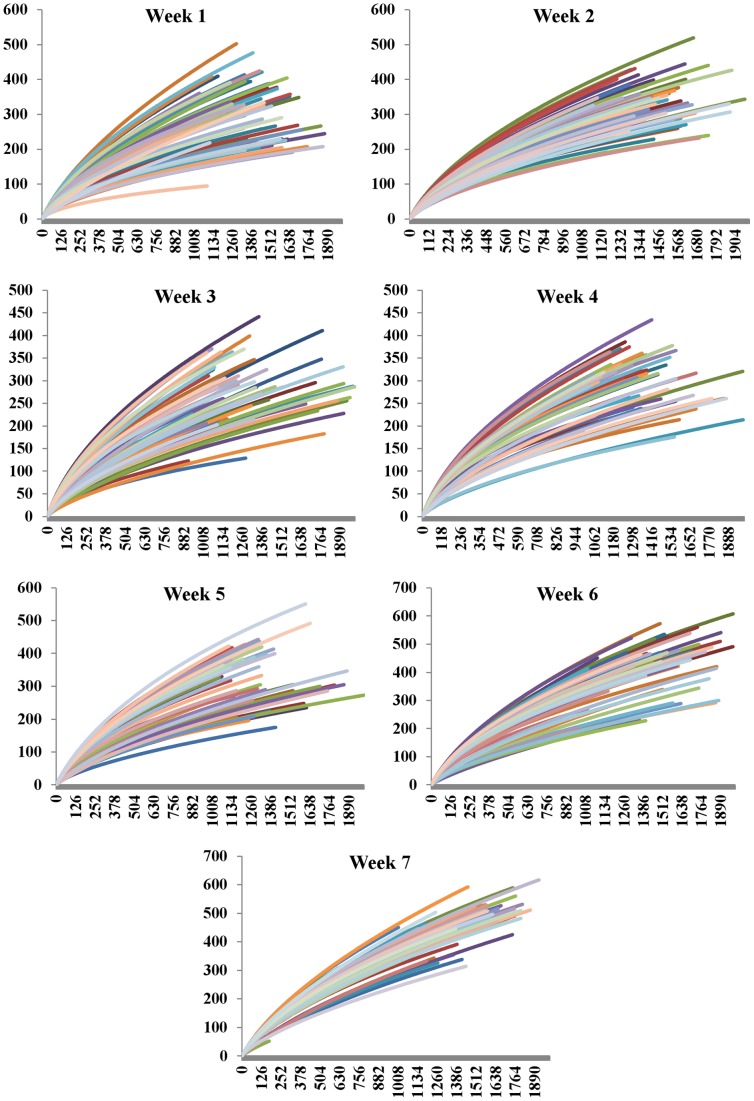
Rarefaction curves of the microbial communities of fecal samples by week of life.Operational taxonomic units (OTU) at a 0.03 distance level.